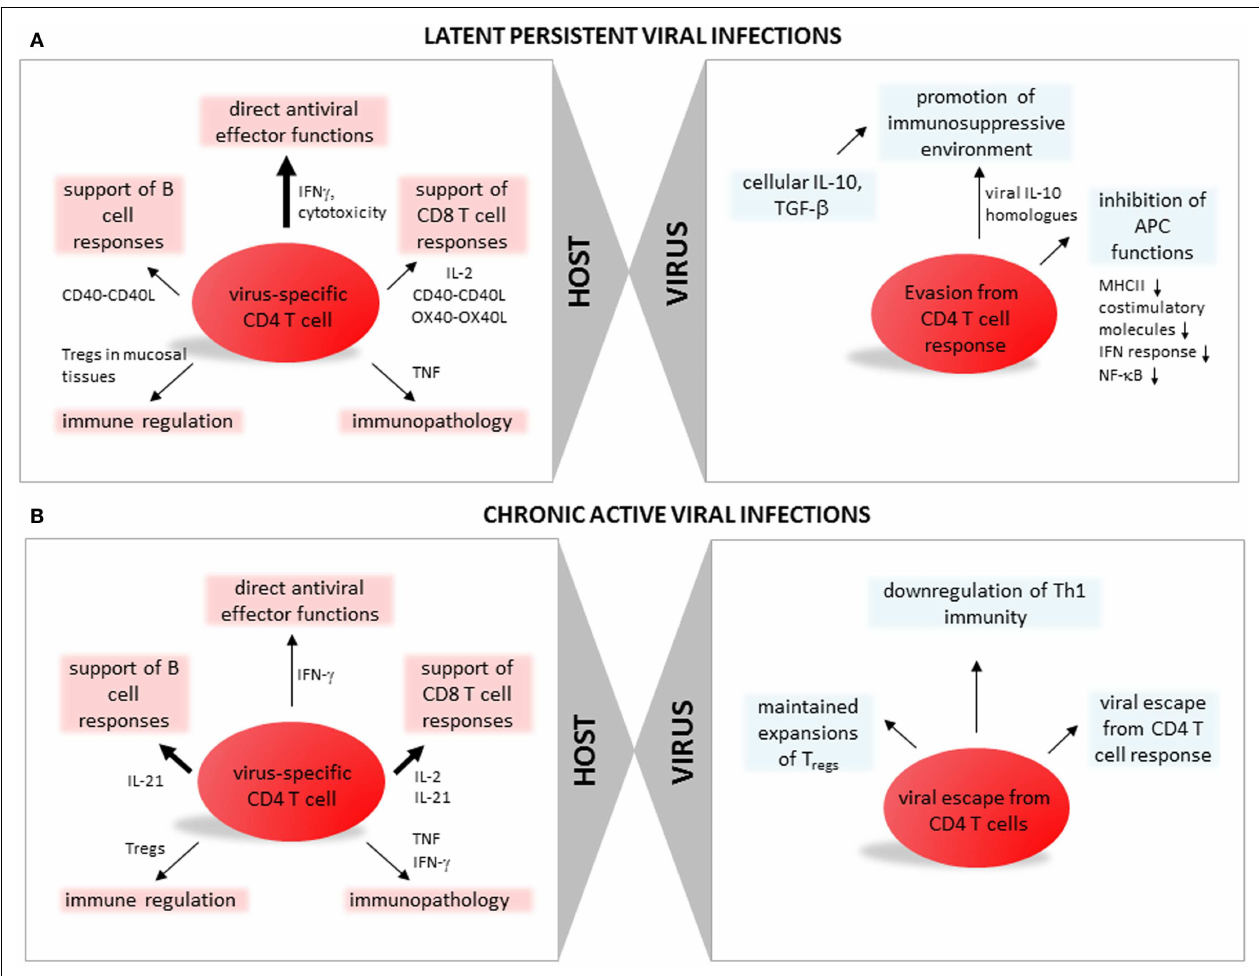
FIGURE 1 | CD4T cell function, differentiation, and regulation during persistent viral infections . (A) Latent persistent viral infections. In the left panel aspects of CD4T cell immune responses with specificity for antigens of latent persistent viral infections are summarized: direct antiviral effector functions (discussed in paragraph Direct Antiviral Effector Functions of CD4T Cells in Latent PersistentViral Infections), support of CD8T cell responses (CD4T Cells SupportVirus-Specific CD8T Cells During Latent PersistentViral Infections), support of B cell responses (CD4T Cells Support Humoral Responses During Latent PersistentViral Infections), immune regulation (Regulatory CD4T Cells in Latent PersistentViral Infections), and immunopathology (Role of CD4T Cells in Latent PersistentViral Infections and IL-10 Producing CD4T Regulatory Cells). In the right panel viral